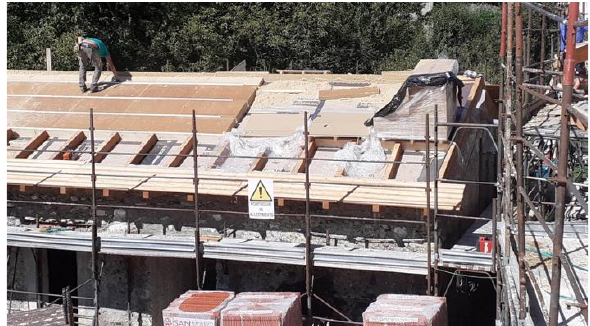
Figure 10. Example of an intervention data sheet.